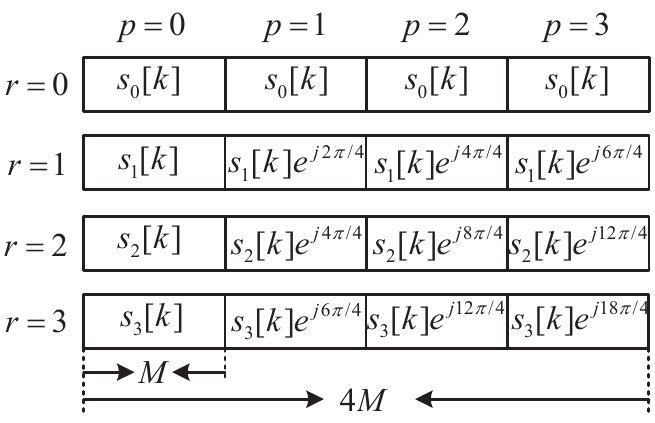
Figure 2. Signal design of ¯ s r [ k ] , taking R = 4 as an